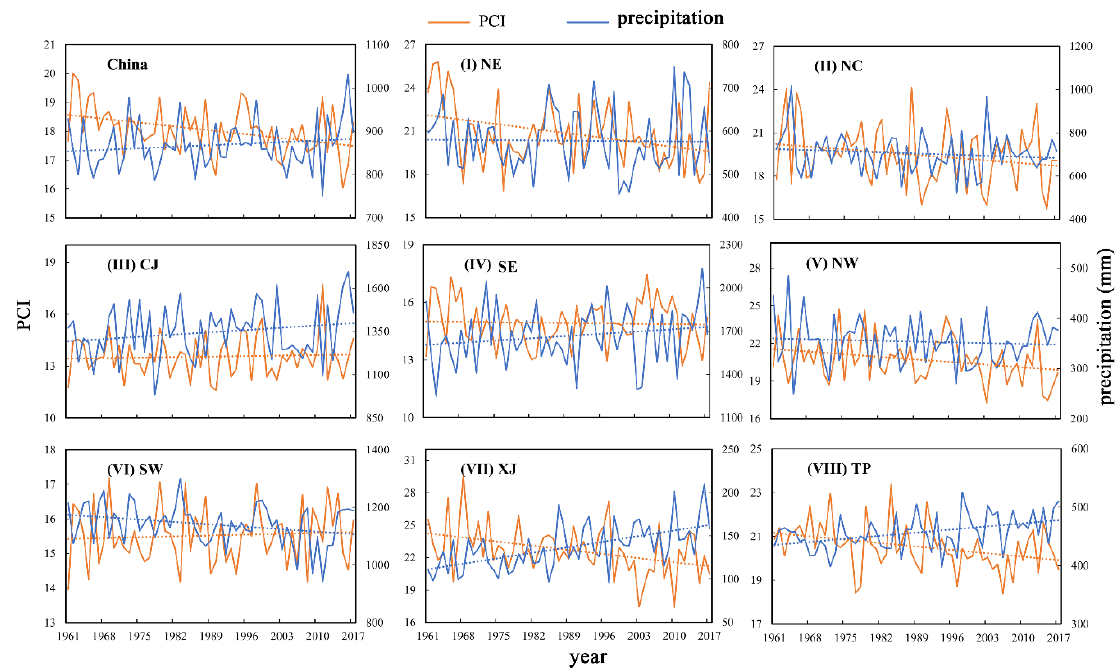
Table 1. PCI trends obtained by the Mann–Kendall for all subregions in China.